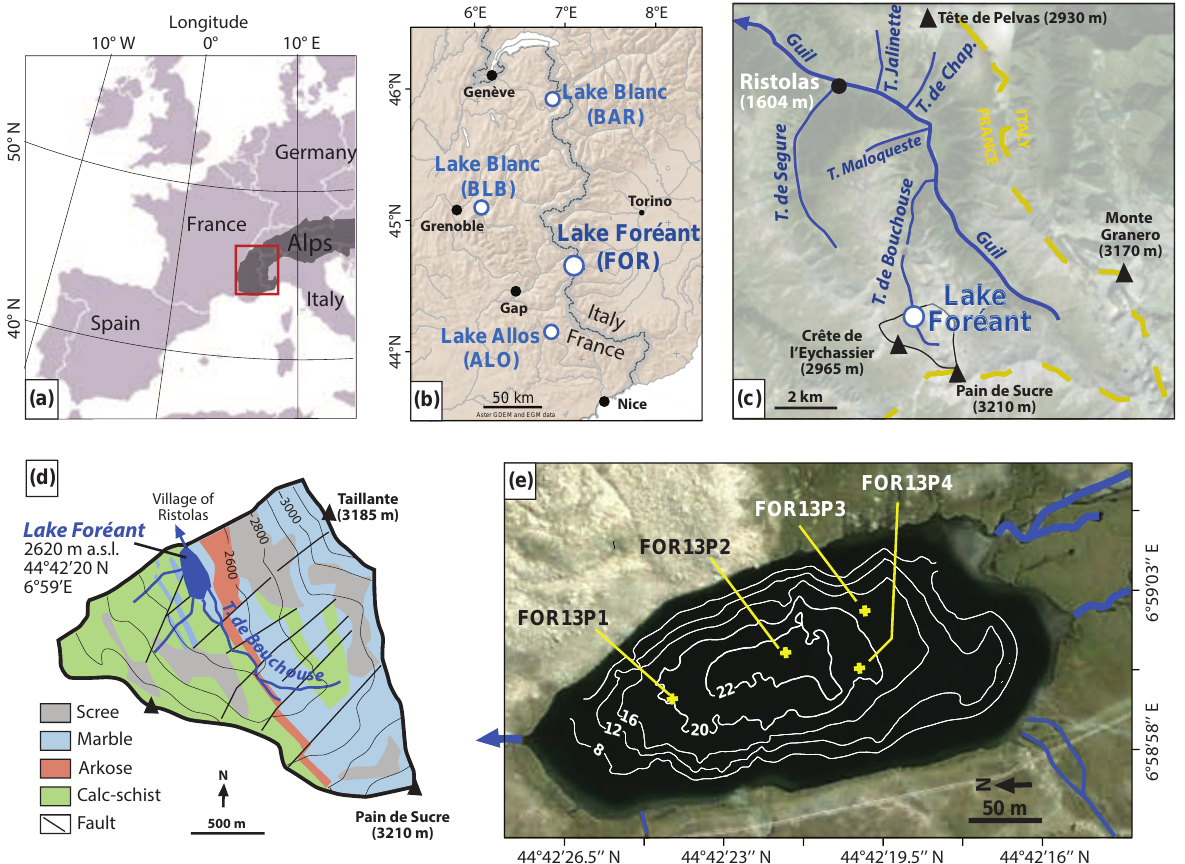
Figure 1. (a) Location of Lake Foréant in the western Alps, (b) compared to the locations of the previously studied Lake Blanc (BLB, Wilhelm et al., 2012b; BAR, Wilhelm et al., 2013) and Lake Allos (ALO, Wilhelm et al., 2012a). (c) Location of the Foréant catchment area in the hydrological network flowing to the village of Ristolas. (d) Geological and geomorphological characteristics of the Foréant catchment area. (e) Bathymetric map of Lake Foréant and coring